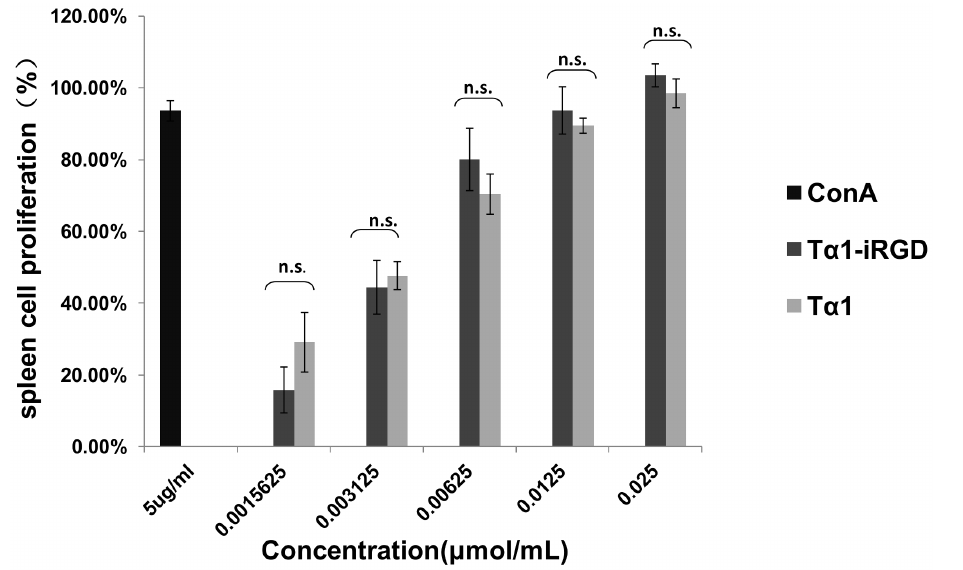
Figure 3. T a 1-iRGD and T a 1 showed similar spleen lymphocyte proliferation activity. Spleen lymphocytes were treated with T a 1-iRGD and T a 1. ConA was used as positive control. All data are expressed as the mean 6 standard deviation, n=4. Statistical analyses were performed with Student’s t-test, n.s., not significant; *p , 0.05; **p , 0.01; ***p , 0.001.